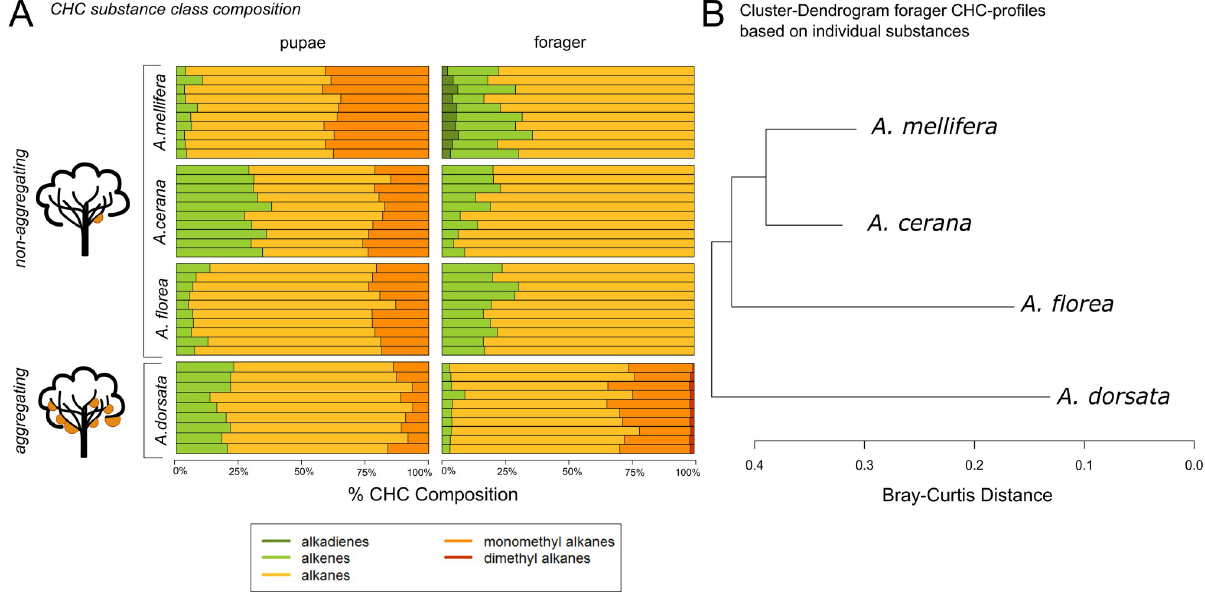
Fig 3. Comparison of hydrocarbon substance classes. (A) Relative proportions of hydrocarbon substance classes (alkadienes: dark green, alkenes: light green, alkanes: yellow, monomethyl alkanes: orange and dimethyl alkanes: red) in the pupal and forager stages in A . mellifera , A . cerana , A . florea and A . dorsata are presented. Each bar refers to one individual per species. (B): Cluster dendrogram of the forager CHC profile based on individual substances is